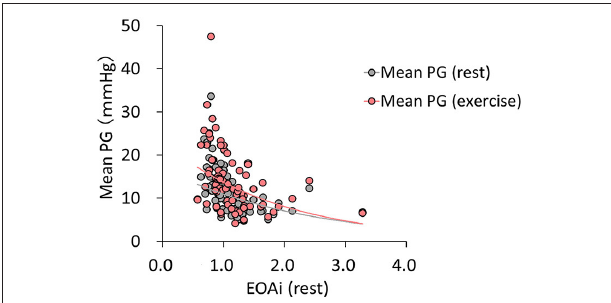
FIGURE 2 | The relationship between the mean PG and EOAi at rest and during exercise. Inverse simple regression analysis of the mean PG and EOAi at rest ( r = 0.421; p < 0.001) and during exercise ( r = 0.440; p < 0.001). Mean PG, mean transvalvular pressure gradient; EOAi, effective orifice area